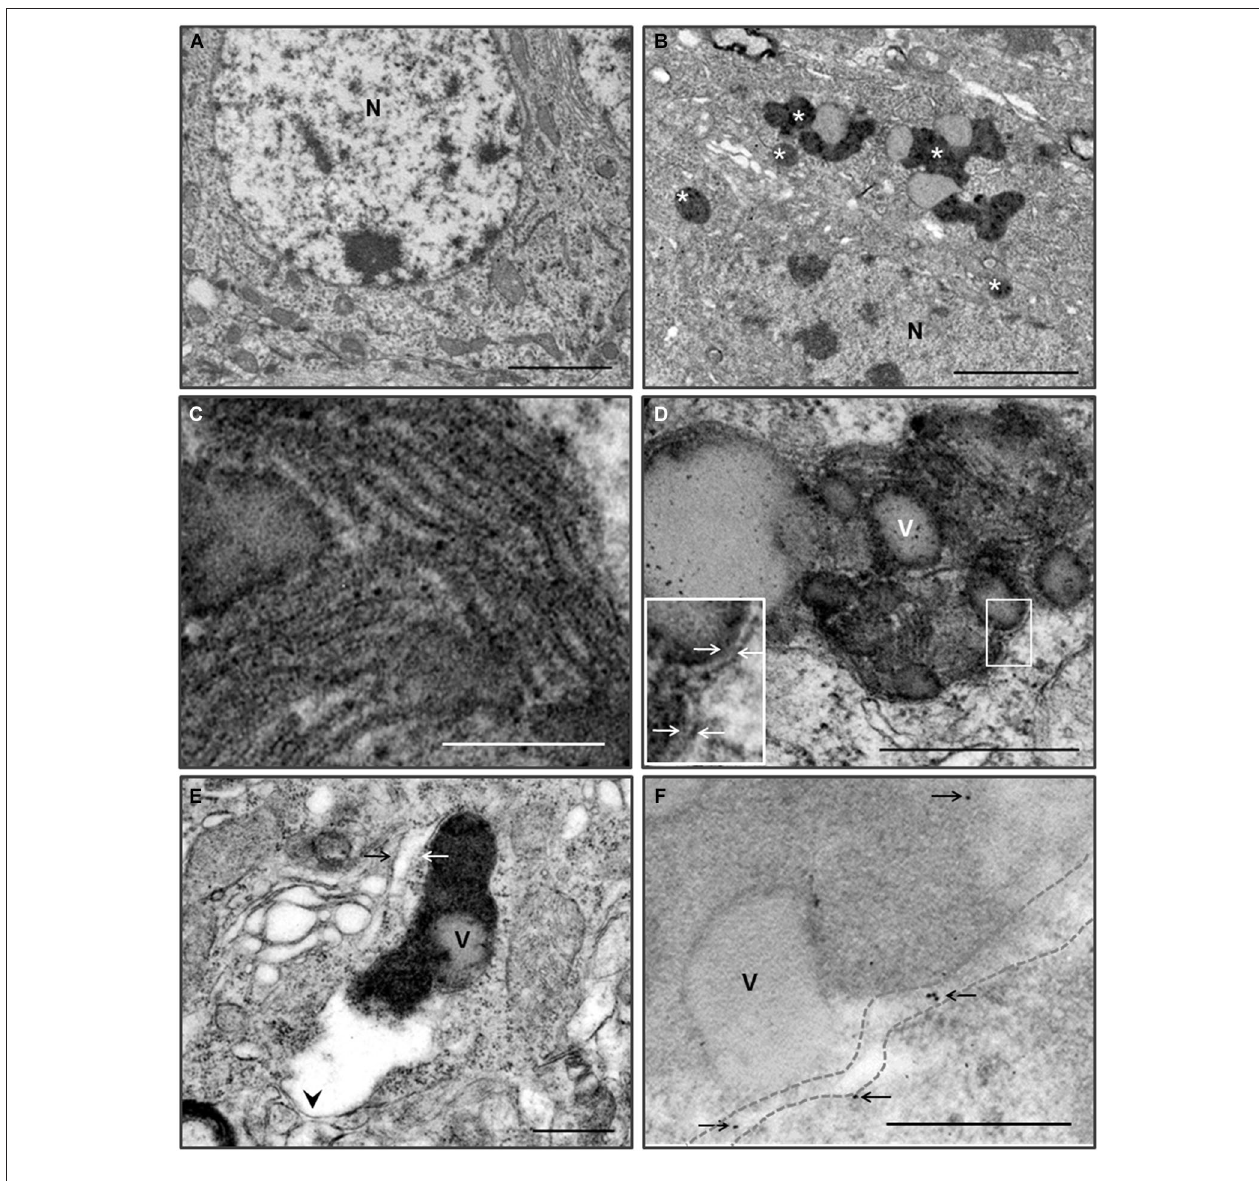
neurons exhibited lipofuscin pigment and electron-lucent vacuoles (v), which were bounded by double membranes (arrows on the higher magnification of solid line boxes). (E) The fine granular pigmented autophagic areas were bounded by single (arrowhead) and double (arrows) membranes. (F) LC3B gold particles (arrows) were localized on the membrane (dotted lines) and in the pigmented electron dense matrix in the cortical neurons of Zürich I Prnp -deficient mice. Scale bars, 2 µ m for (A,B) ; 100 nm for (C) ; 500 nm for (D–F)